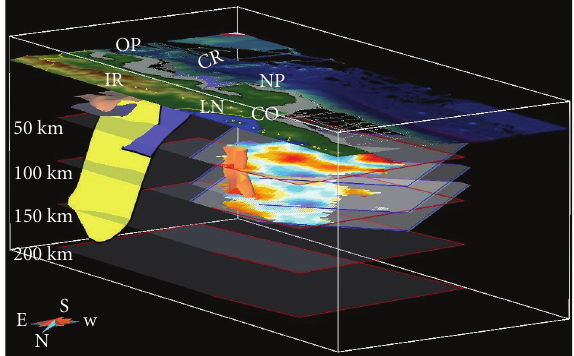
Figure 11: Perspective view from the north into the Central American lithosphere down to a depth of 200 km as it resulted from receiver function analysis (Dzierma [45, 46]) and seismic tomography (Dinc-Akdogan et al. [47, 48]). On top of the viewing box the surface topography on- and o ff shore is portrayed. The downgoing slab of the Nasca Plate (yellow color) and some other interfaces of lithospheric boundaries based on receiver function analysis are presented in the southeastern region below Costa Rica. Distribution of Vp velocities (at depths of 50, 80, and 100 km) bases on tomographic investigations are presented in the northwerstern region below the Lago Nicaragua (LN). A low-velocity domain (orange colors) points to ascending magmatic material, which feeds the Concepci´on volcano (CO). For more details refer to the text.